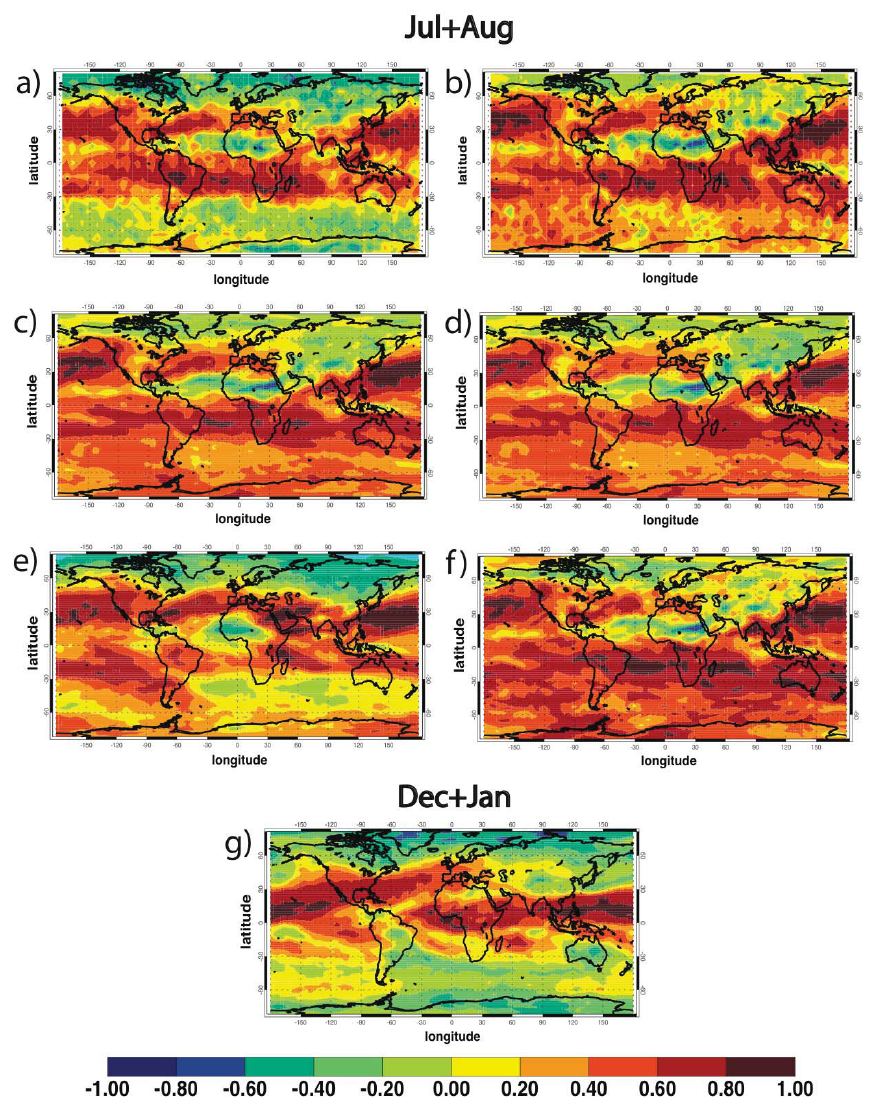
Fig. 6. Testing the robustness of G-PUCCINI 2005–08 correlation coefficients seen in Fig. 3: (a) same as Fig. 3c but without the observational error; (b) same as (a) but without the TES operators application; (c) same as (b) but without the TES sampling (i.e. raw model output); (d) same as (c) but for 562hPa instead of 800–400hPa average; (e) same as (c) but for 316hPa instead of 800–400hPa average; (f) same as (c) but calculated using 5-daily (quasi-weekly) averages instead of daily. Also, we show the correlations from the raw model output for December–January in (g) (compare with Fig.